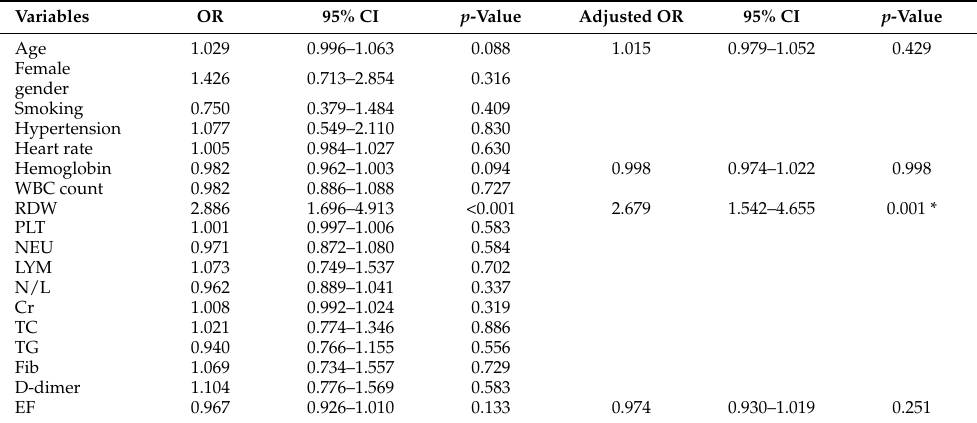
Table 4. Logistic regression analysis of predictors of no-reflow in the DM